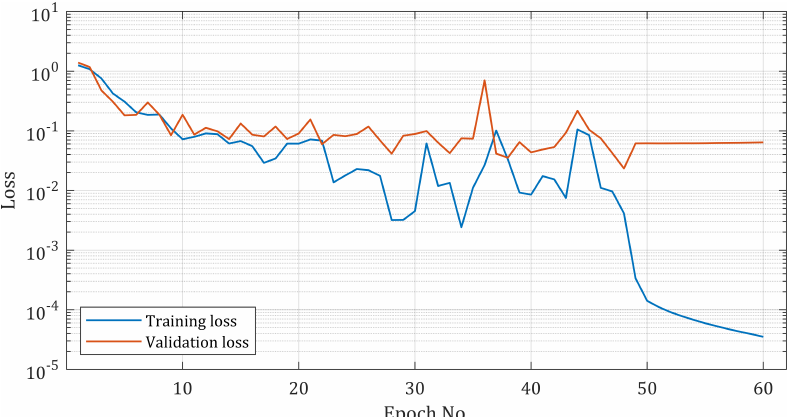
Figure 10. Training and validation loss during training process.